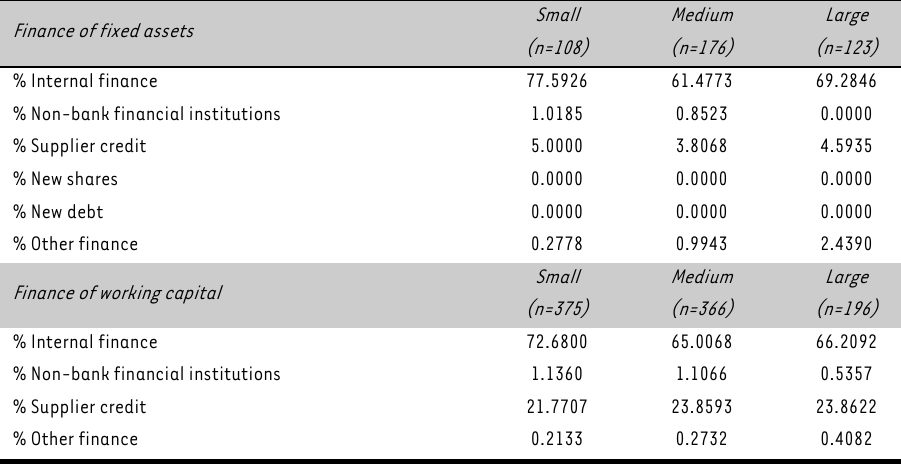
Sources of finance and firm